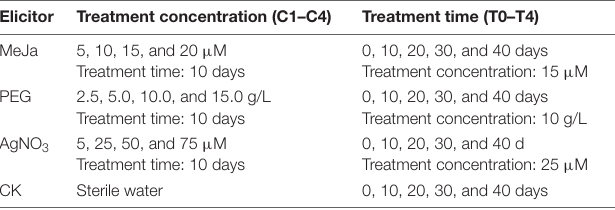
TABLE 1 | Treatment conditions for three abiotic